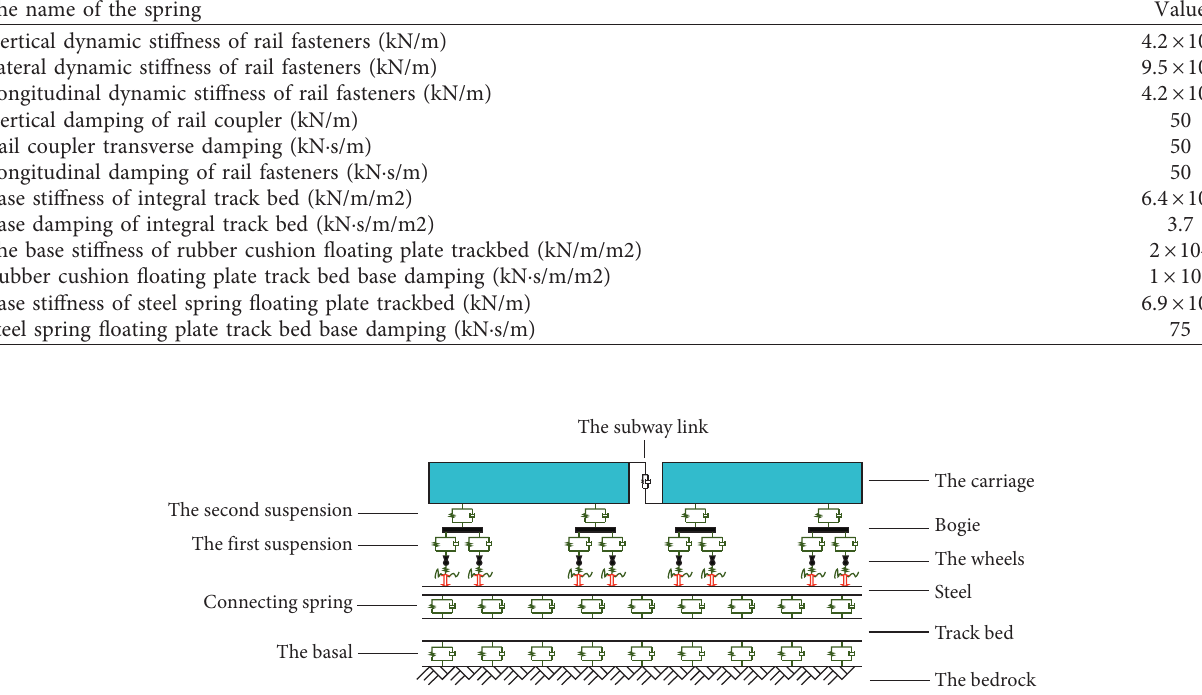
Figure 3: Vehicle-rail coupling diagram.